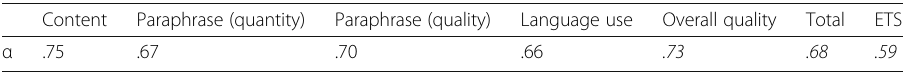
Table 3 Inter-rater reliability coefficients ( N = 6) Content